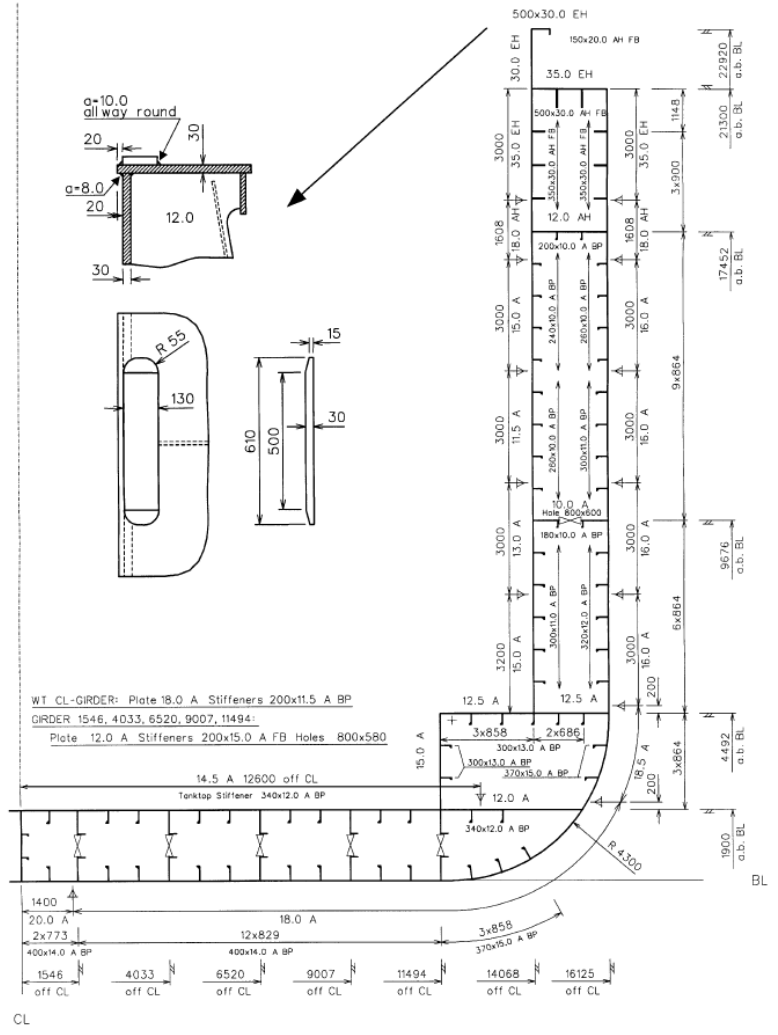
Figure 15. Detail of the longitudinal coaming of a Panamax container analyzed by Fricke et al. [31]. Reprinted with permission from ref. [31]. Copyright 2002 Elsevier.